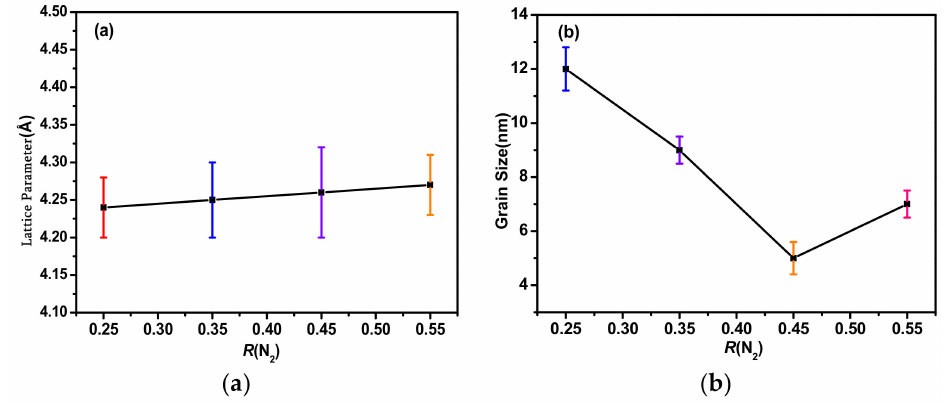
Figure 3. ( a ) Lattice parameter and ( b ) grain size of the TiN coating at different R (N 2